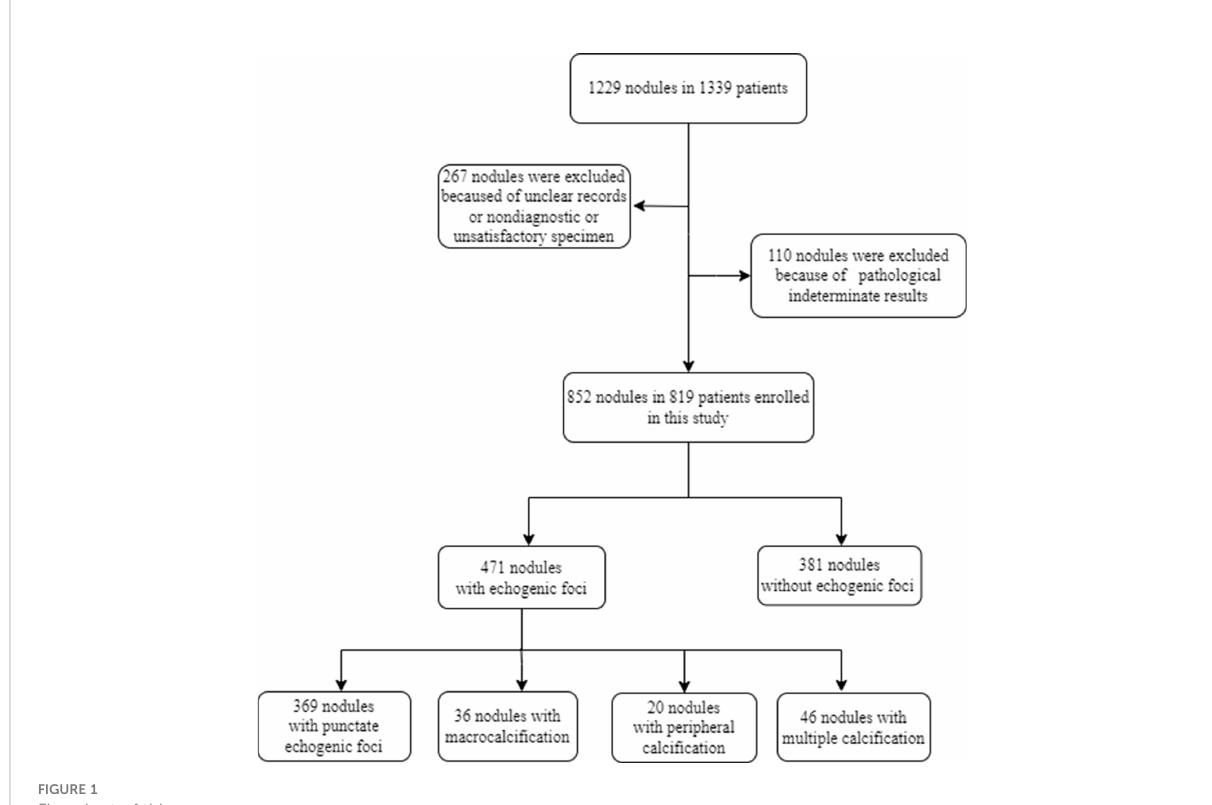
FIGURE 1 Flowchart of this